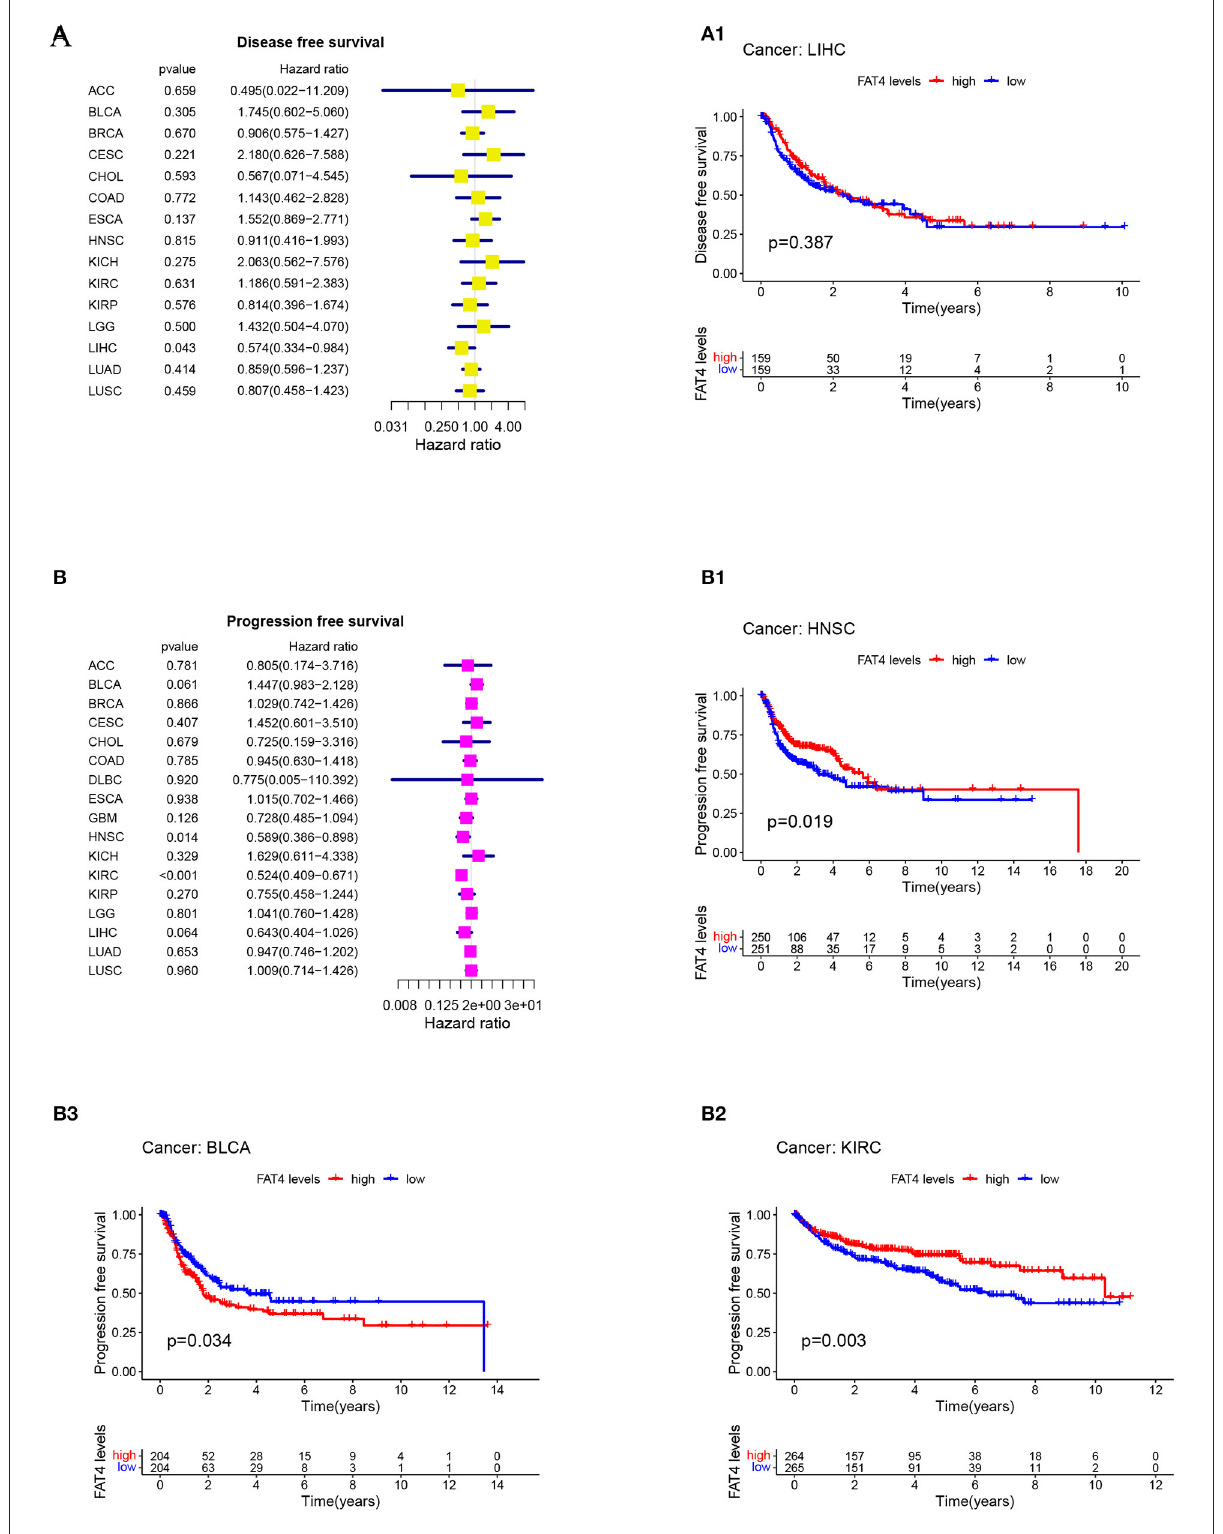
FIGURE4 Correlation between FAT4 expression and survival prognosis of cancers. (A,B) Forest plots of DFS and PFS. (A1–B3) Kaplan-Meier curves for DFS and